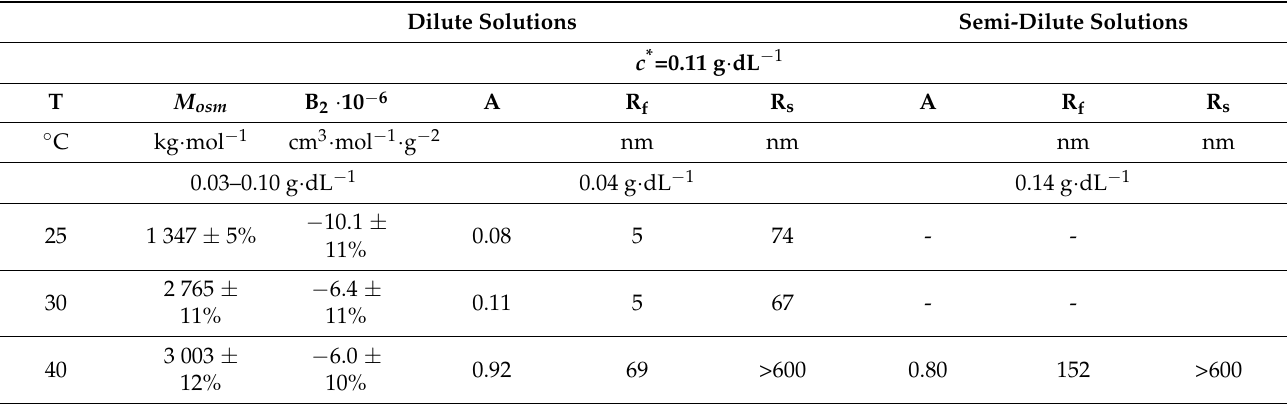
Figure 3. Intensity of autocorrelation function versus delay time for Plantago ovata raw husk extract of 0.04 and 0.14 g · dL − 1 at selected temperatures. Table 1. Osmotic and hydrodynamic parameters of raw Plantago ovata husk